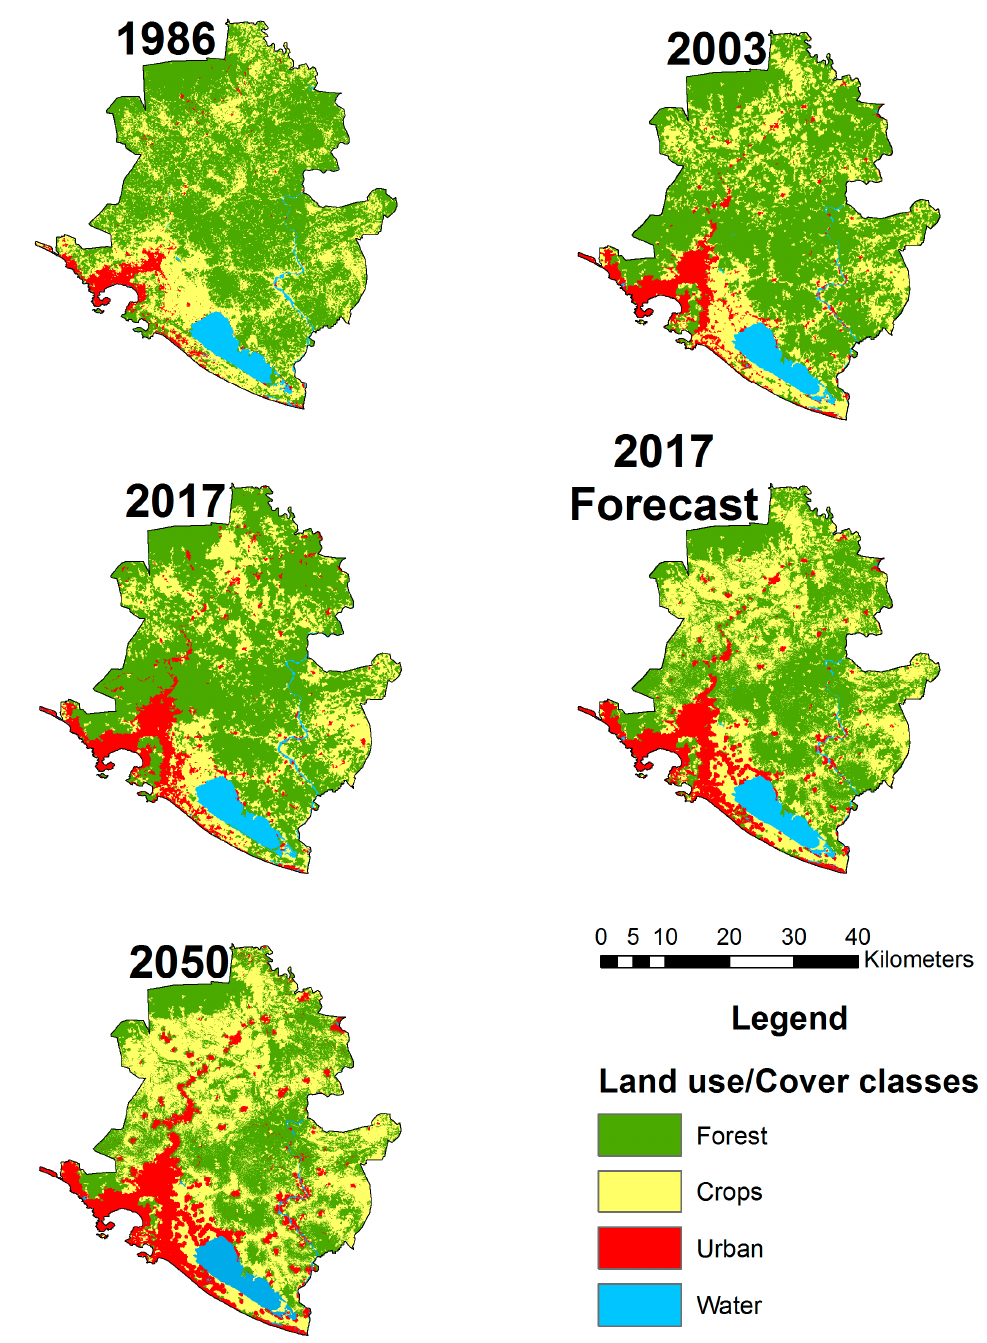
Figure 4. Supervised classification of Acapulco de Juárez 1986–2050.